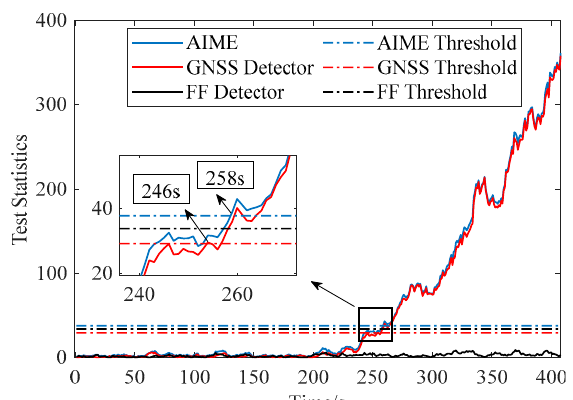
Figure 7. Fault detection for GNSS ramp fault occurring in SV-3 ( 𝑃 (cid:3007)(cid:3002)(cid:3008) = 0.9𝑃 (cid:3007)(cid:3002) ).